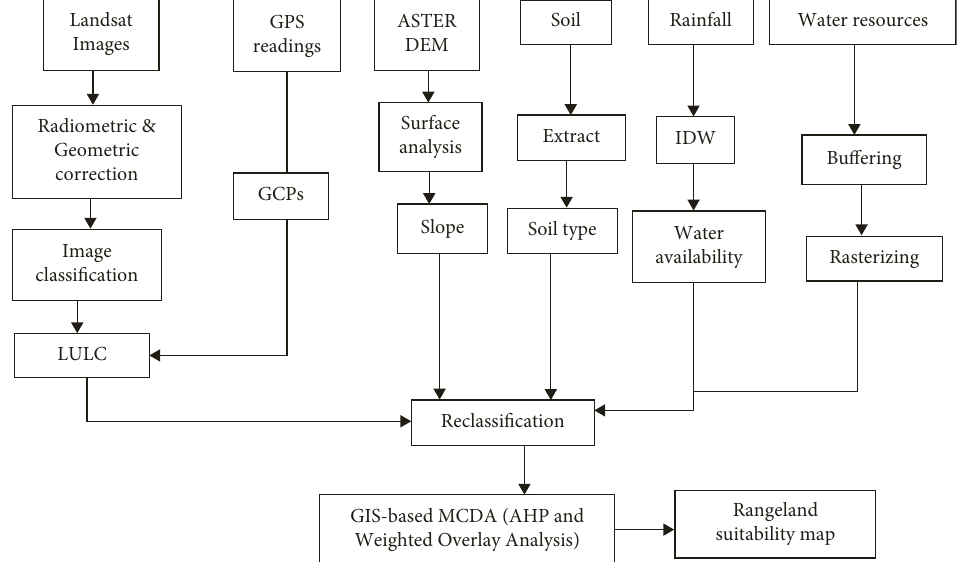
Figure 7: Methological flow diagram of the